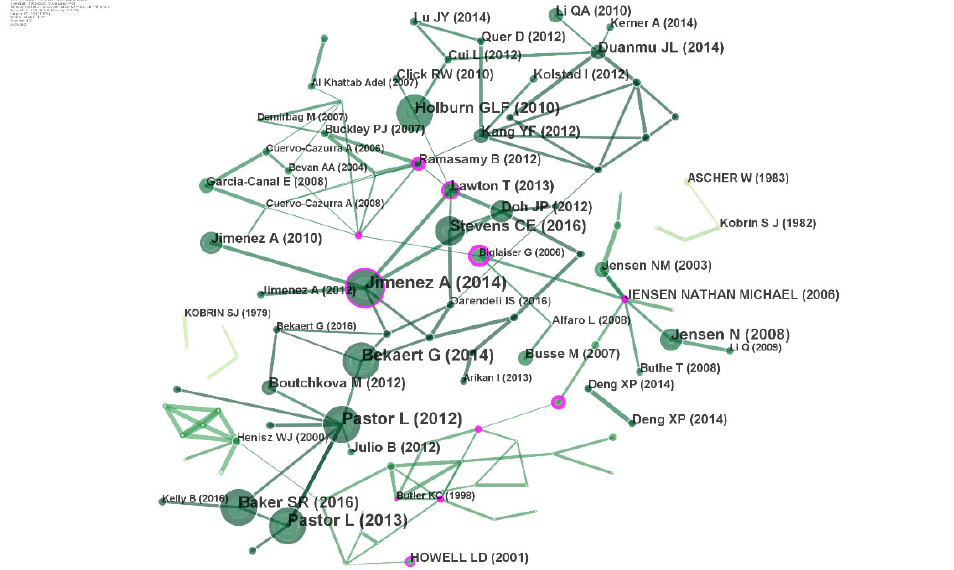
Fig . 6. Reference co-citation graph of political risk related papers in WoS